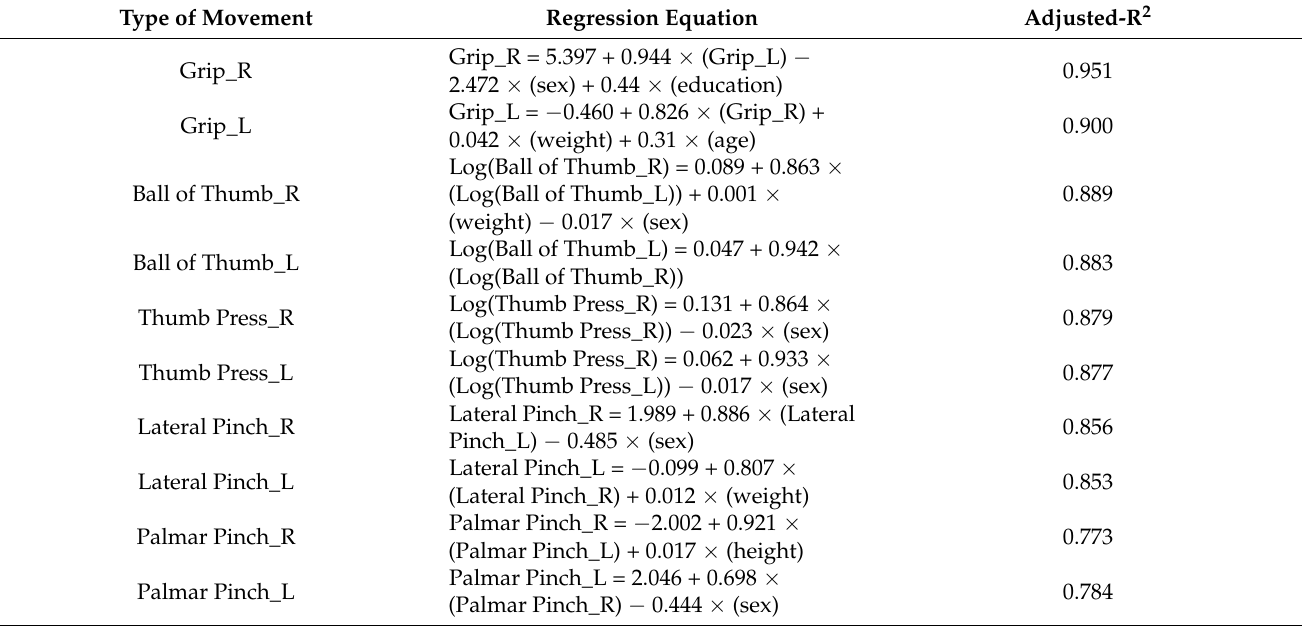
Table 7. Strength prediction models for different types of hand movement stratified by hand using demographic and anthropometric data, and opposite hand strength of the same hand movement.